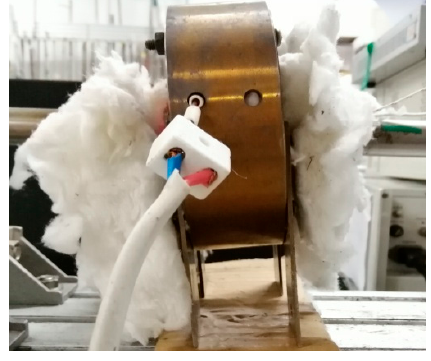
Figure 8. Experimental device.